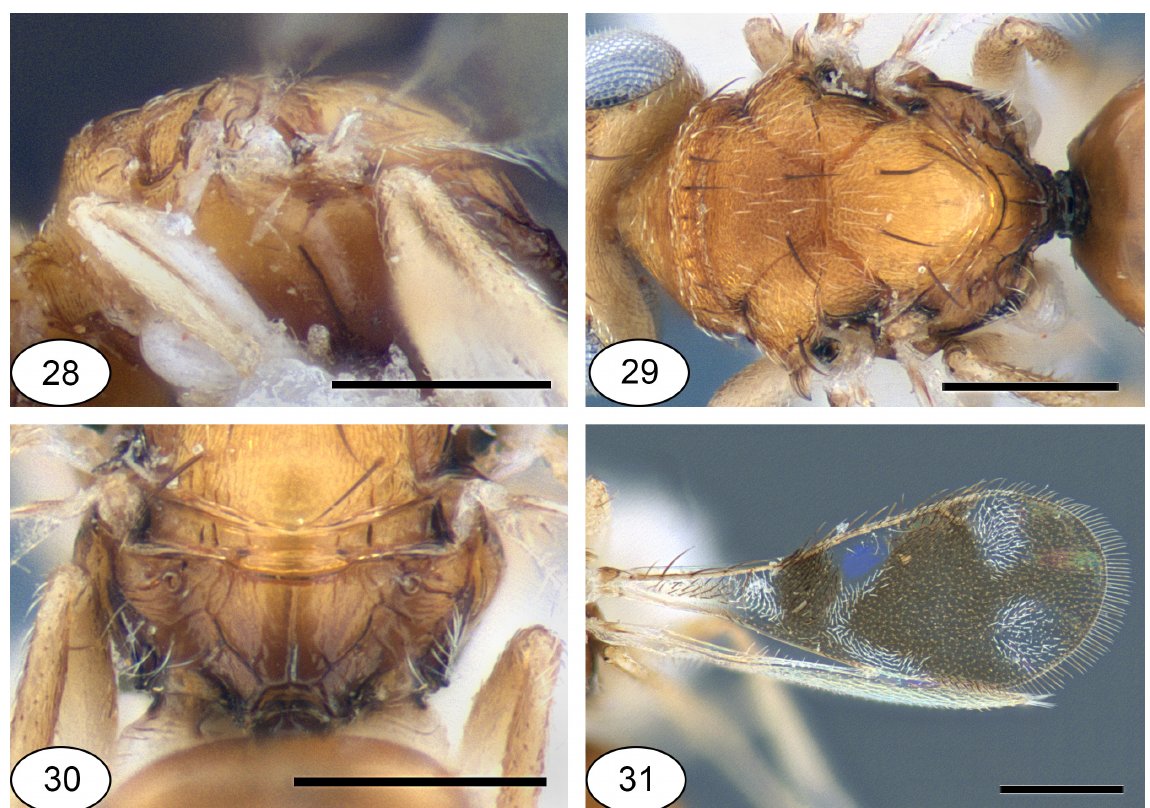
Figs 28–31. Netomocera amethysta sp. nov., holotype, ♀. 28 . Mesosoma, lateral view. 29 . Mesosoma, dorsal view. 30 . Propodeum, dorsal view. 31 . Fore and hind wings. Scale bars: 0.2